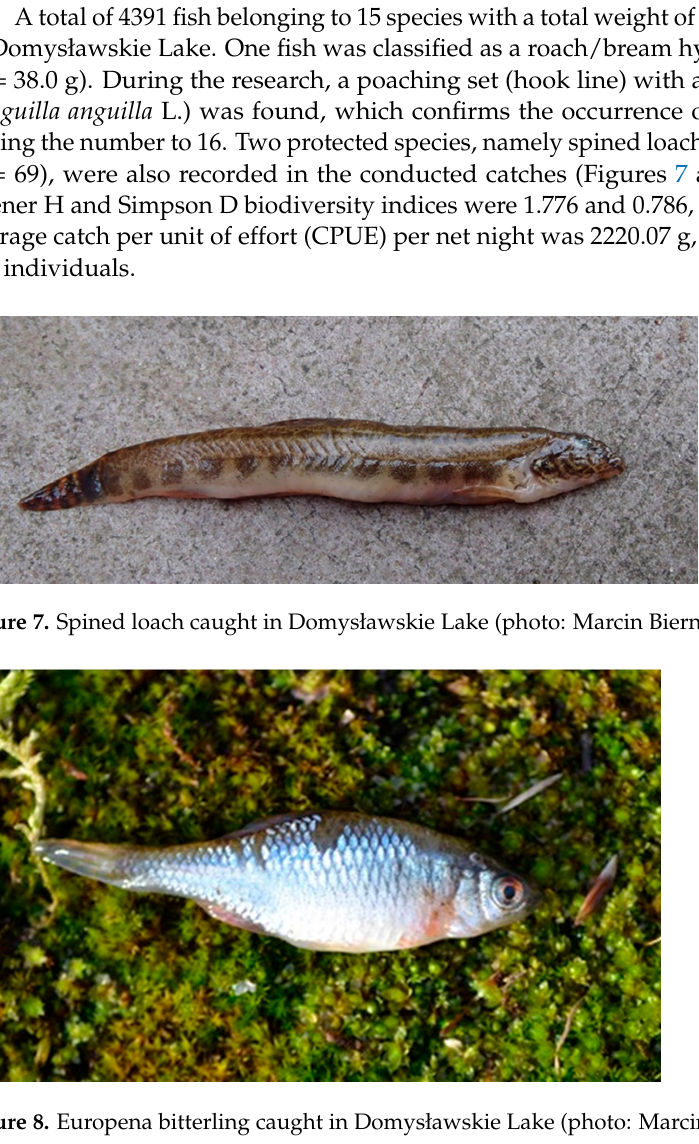
Both in terms of numbers and weight, the catch was dominated by non-predatory fish such as asp, prussian carp, gudgeon, goatfish, white bream, tench, roach, bitterling,